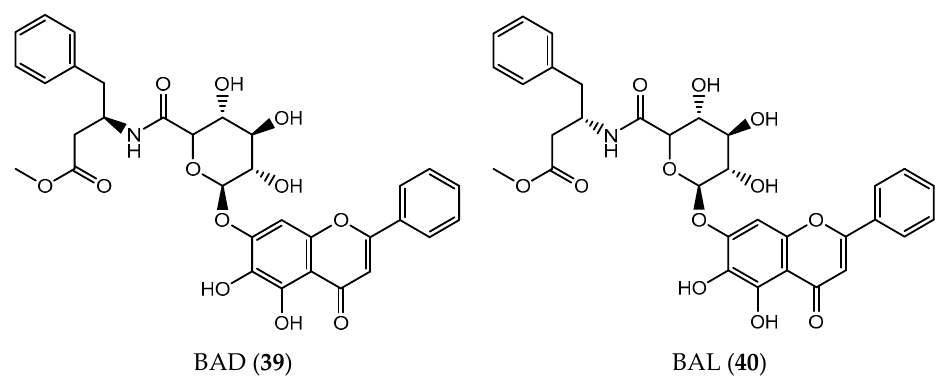
Figure 14. Chemical structure of baicalin derivatives, BAD ( 39 ) and BAL ( 40 ).